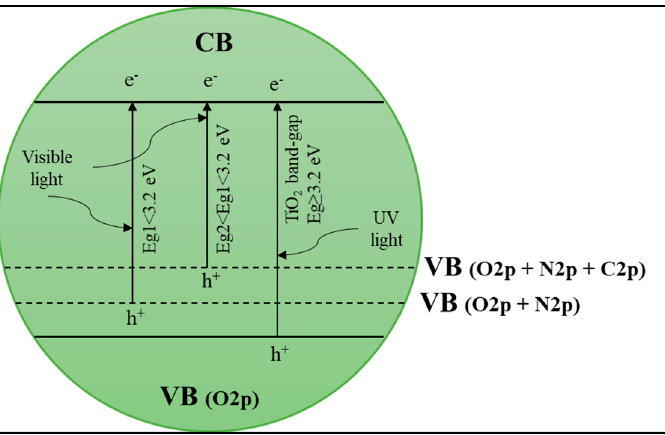
Figure 18. Schematic of new energy bands formation in C–N–TiO 2 photocatalyst. Cation–Cation Dopants